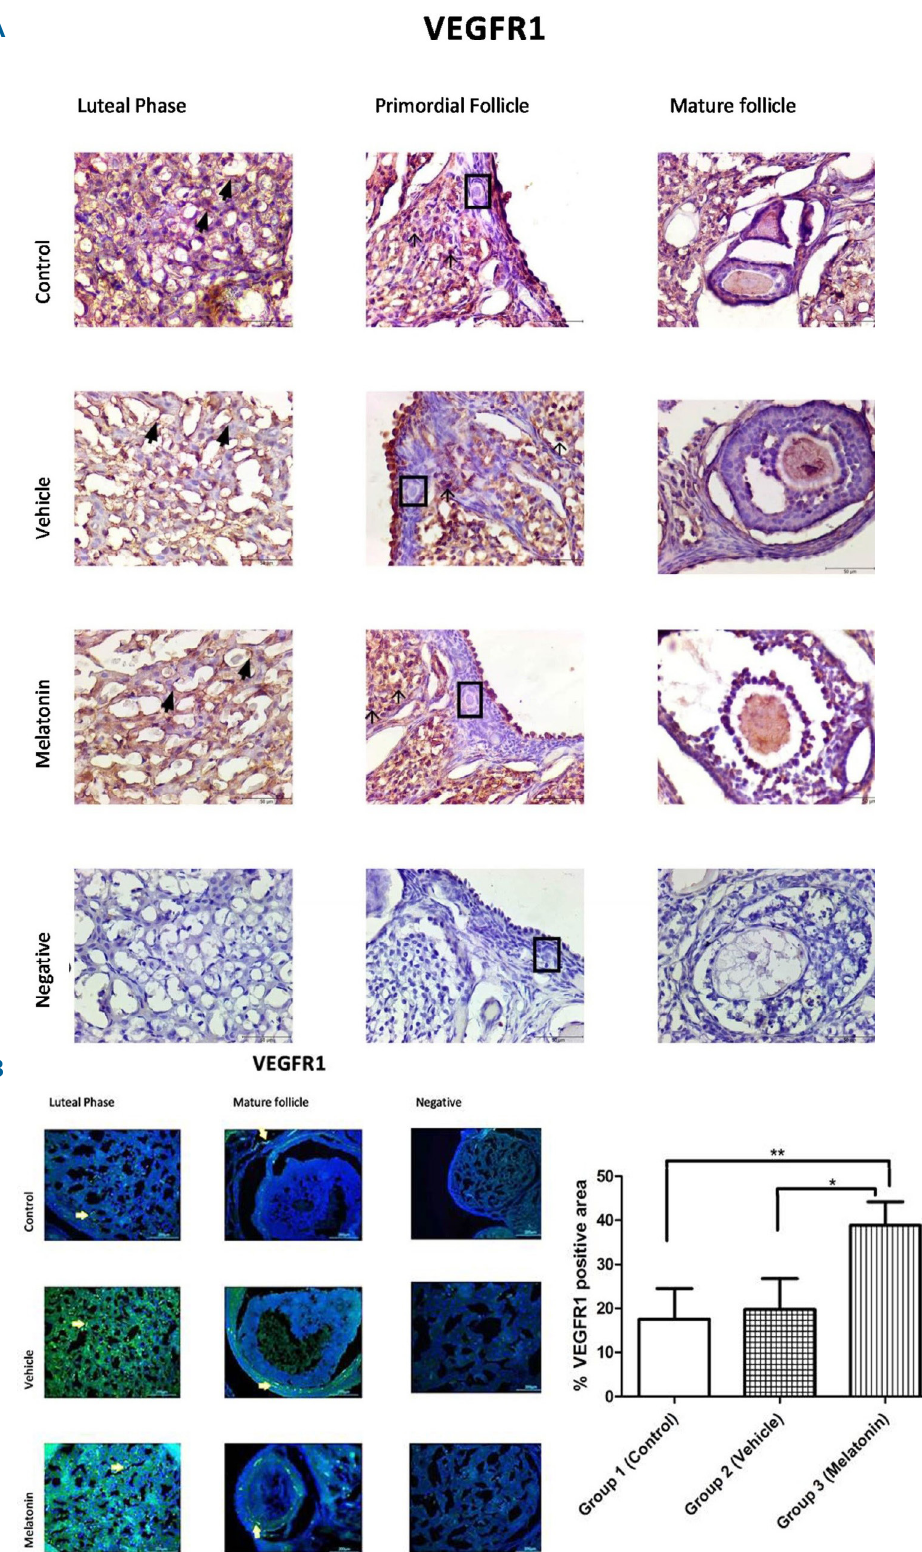
A: Immunohistochemical staining, B: Immunofluorescence staining. Immunoreactivity of VEGFR1 proteins in Group 1 (control), Group 2 (vehicle), and Group 3 (melatonin). An increase in the immunoreactivity of VEGFR1 in theca cells (as indicated by yellow arrows) can be seen in the melatonin treatment group. Data are displayed as the mean ± S.E.M.; n=15 rats/group.**, p <0.05 indicates significance compared to the respective control values. *, p <0.05 indicates significance compared to the respective vehicle values. Figure 4 - Immunoreactivity of VEGFR1